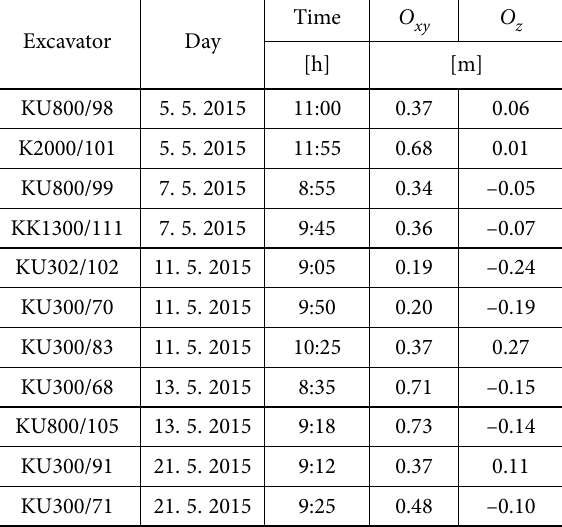
Table 6. Results of the control measurements at Bílina mine